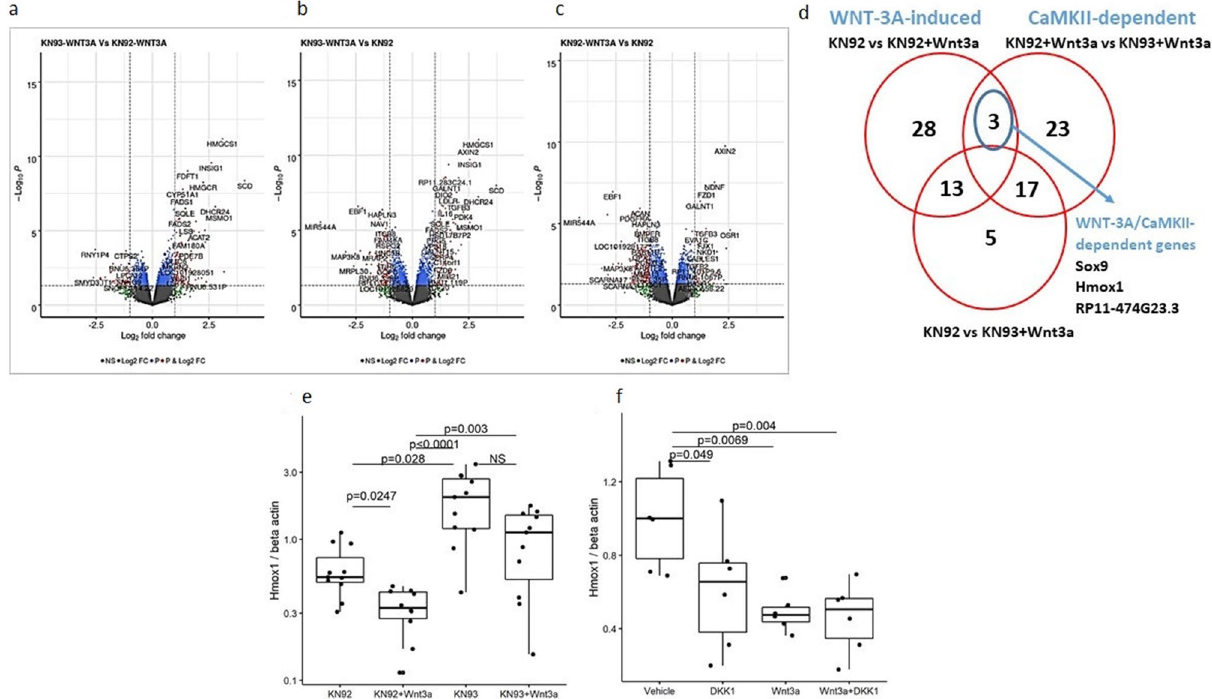
Figure 1. HMOX1 is a selective target of the WNT/CaMKII pathway in the articular chondrocytes. ( a – d ) Human articular chondrocytes isolated from OA patients were treated with human recombinant WNT3A in presence of the CaMKII inhibitor KN93 or its inactive control molecule KN92. ( a ) Volcano plot showing genes regulated by WNT3A (KN92 + WNT3A vs KN92), ( b ) genes modulated by CaMKII inhibition in the presence of WNT3A (KN93 + WNT3A vs KN92 + WNT3A) and ( c ) genes activated by WNT3A independently of CaMKII (KN93 + WNT3A vs KN92). ( d ) Venn diagram showing the number of significantly modulated genes in each group. ( e ) qPCR confirming downregulation of HMOX1 in response to WNT3A but not in the presence of the CaMKII inhibitor KN93. Microarray data were obtained by testing samples from 4 human